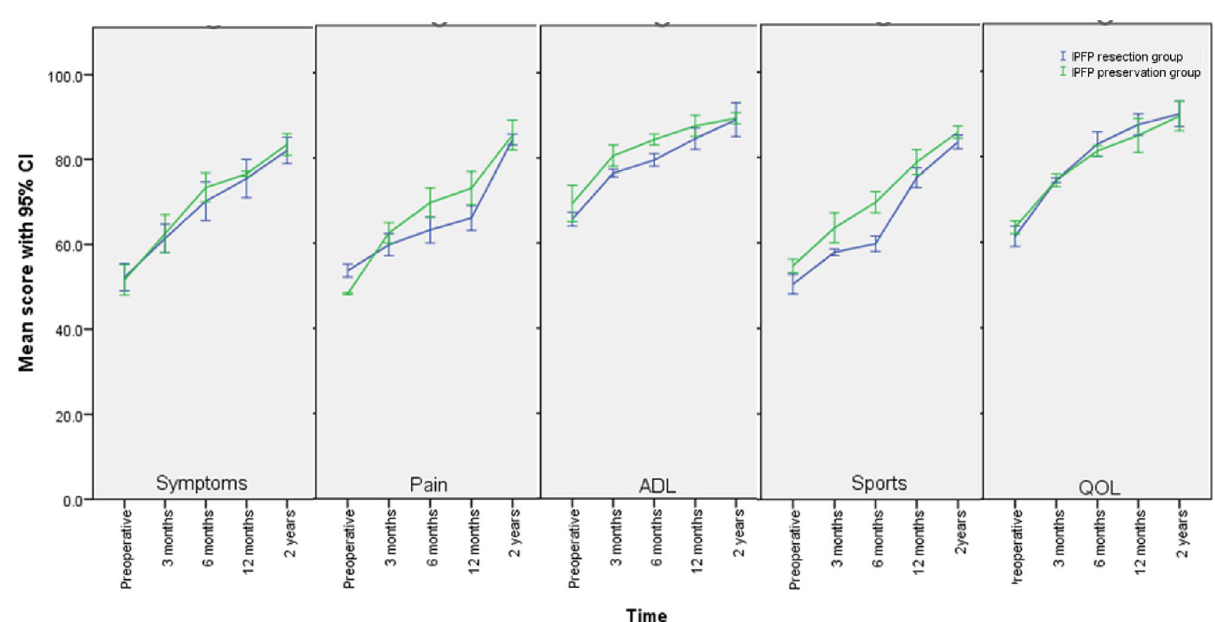
Figure 5. The KOOS subclass mean scores for both groups at different intervals with a 95% confidence interval (CI) ( IPFP infrapatellar fat pad, ADL activities of daily living, QOL quality of